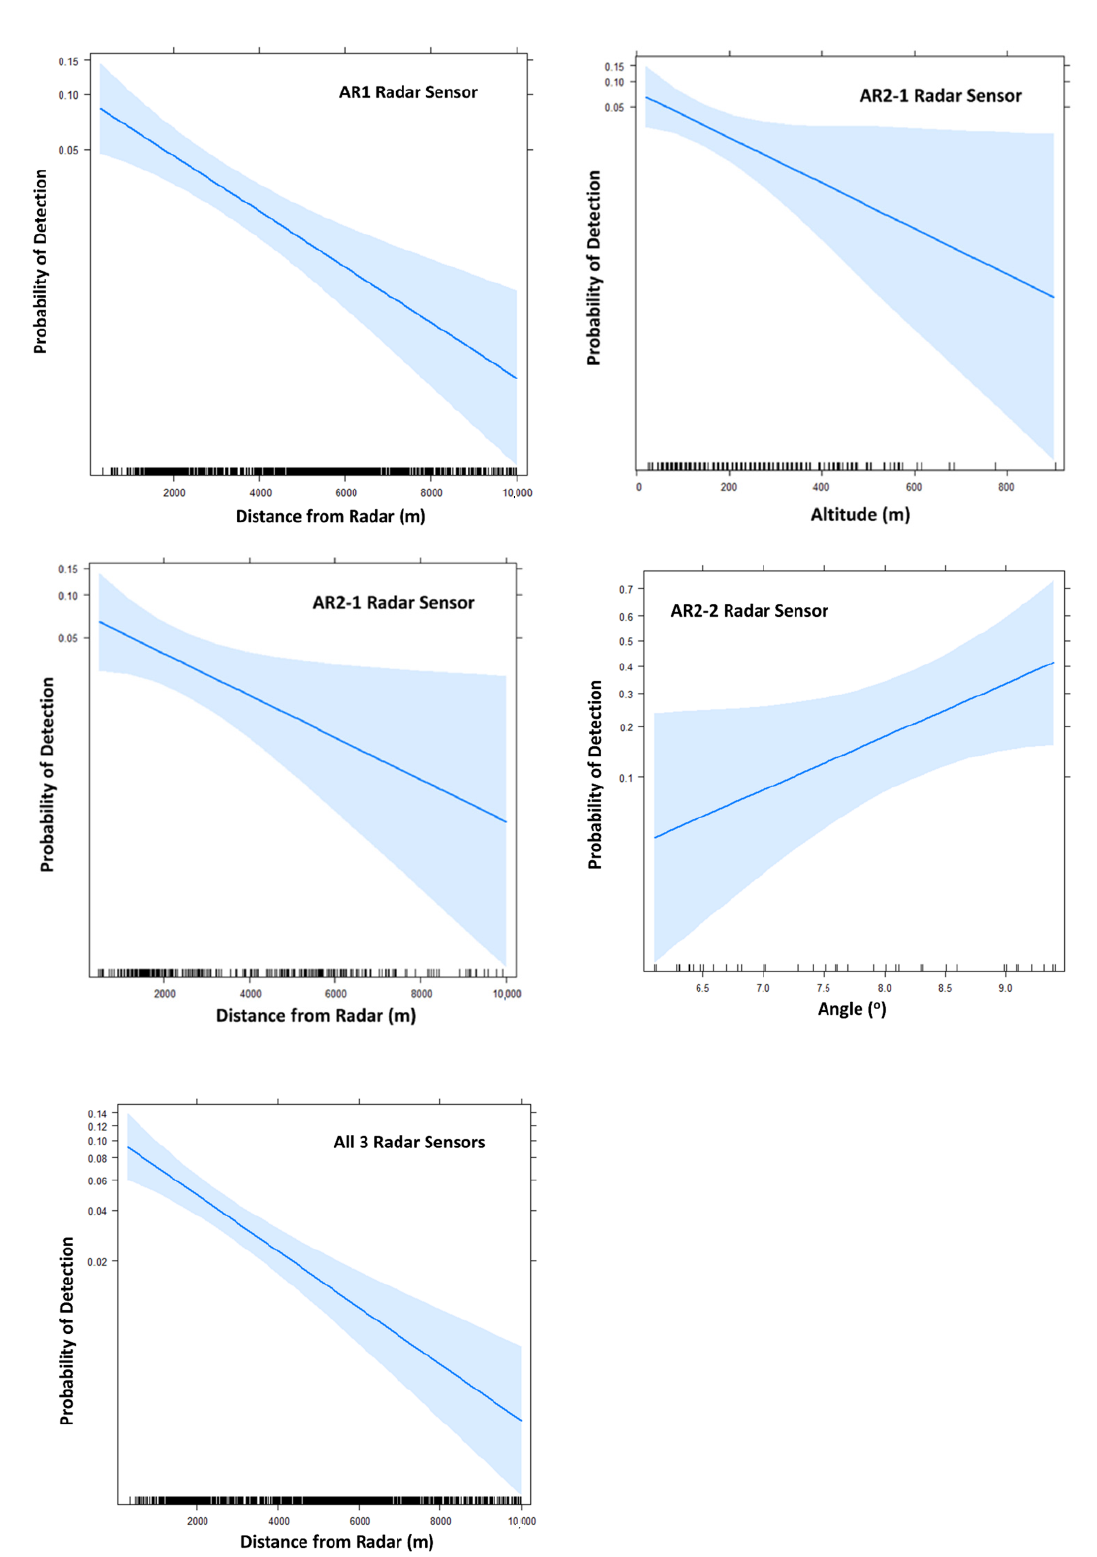
Figure 4. Effects plots for variables found to be important in influencing the performance of the AR1, AR2-1, and AR2-2 radars for red-tailed hawks during a study at Chicago’s O’Hare International Airport, USA, from September 2010 to May 2014. These graphs visualize the partial slope for a given factor when the other predictors are held fixed (represented by the dark blue line). The blue shaded area is a pointwise confidence band for the fitted values, based on standard errors computed from the covariance matrix of the fitted regression coefficients.